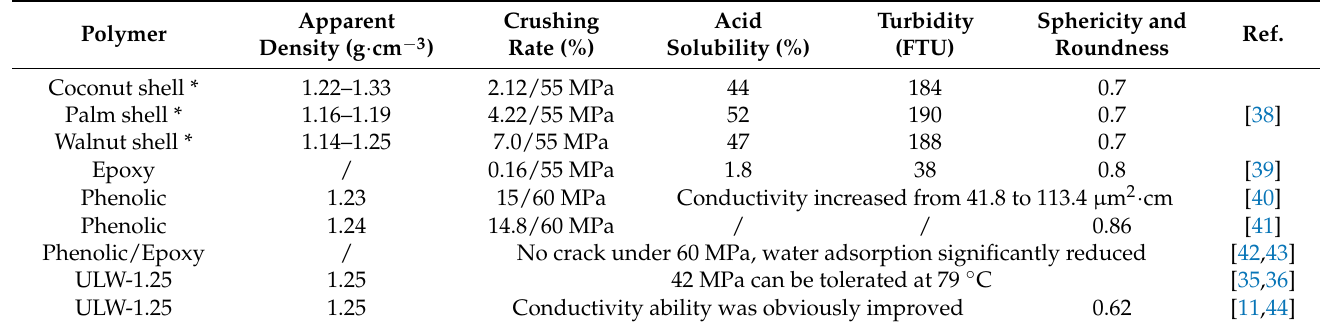
Table 6. Properties of polymer coated bio-based nutshell